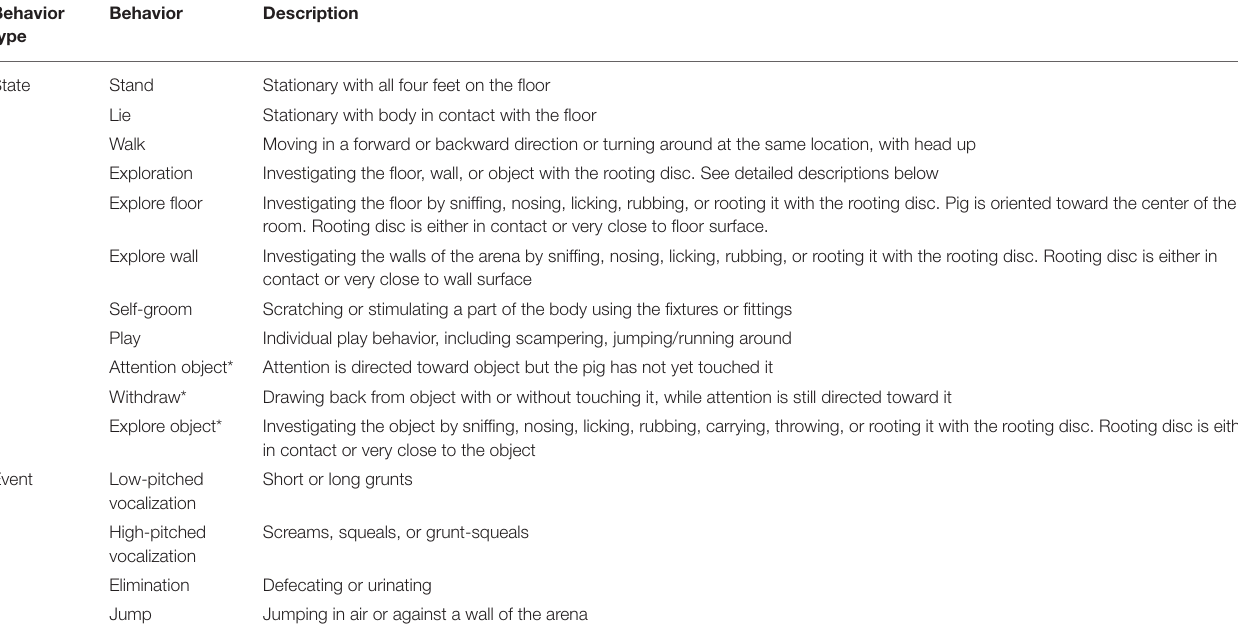
TABLE 1 | Ethogram of behaviors recorded by continuous observation during the open field and novel object tests. Behavior